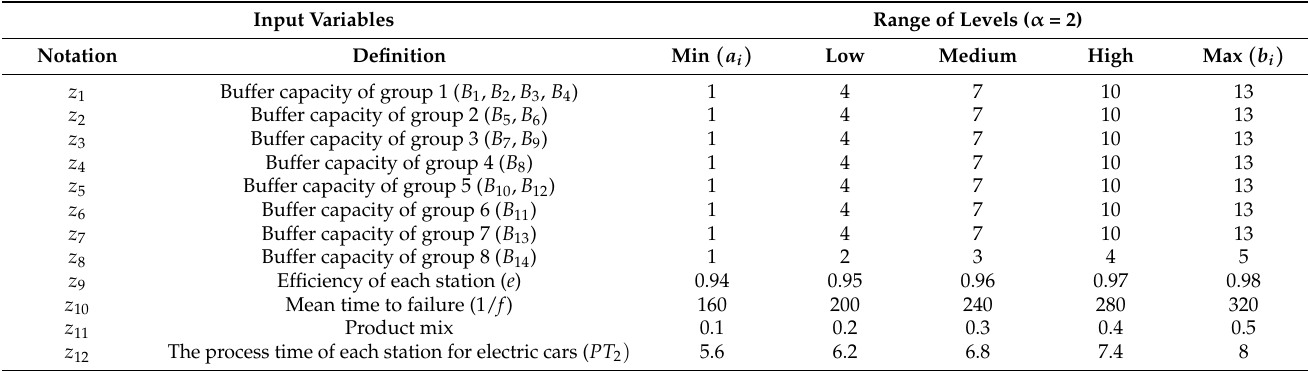
Table 4. Definitions of input variables and the ranges of